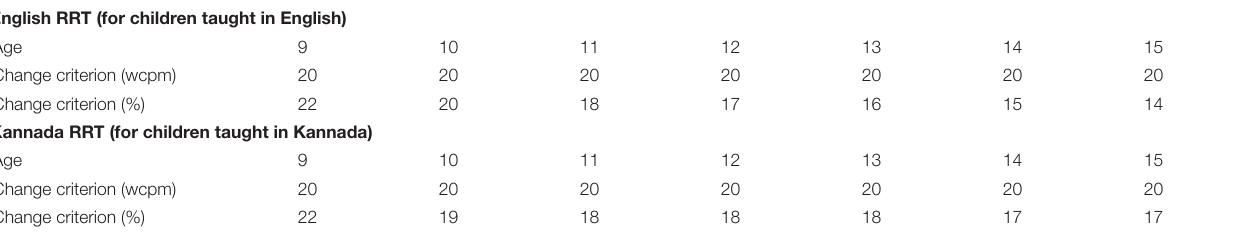
TABLE 6 | Suggested criteria for change in reading rate, by test and